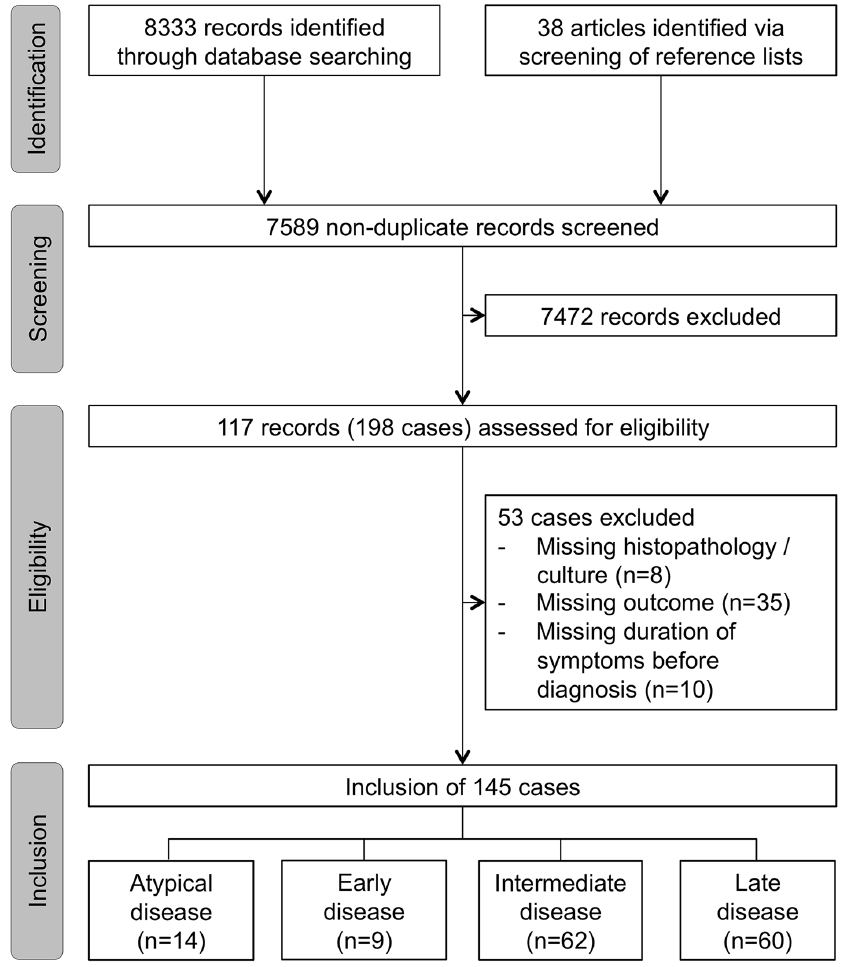
Fig 5. Flow chart of the selection of published cases on rhinoentomophthoromycosis. All cases assigned to staging analysis (n = 145) were included in the statistical analysis.